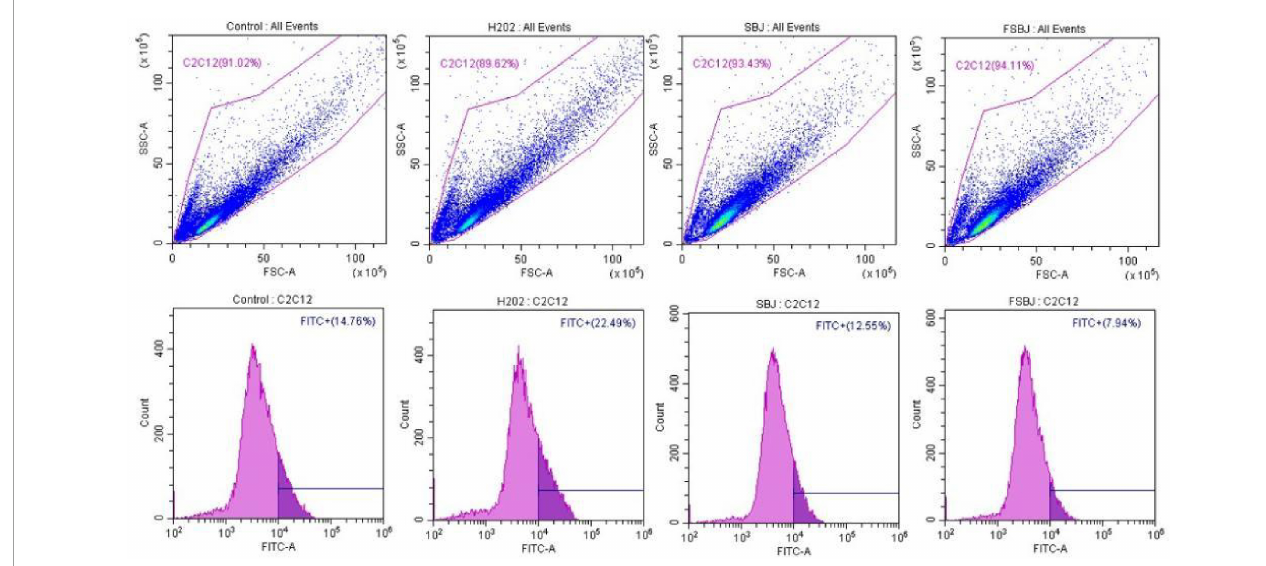
FIGURE8 The inhibitory effect of SBJ and FSBJ on H 2 O 2 -induced intracellular ROS production in C2C12 cells.